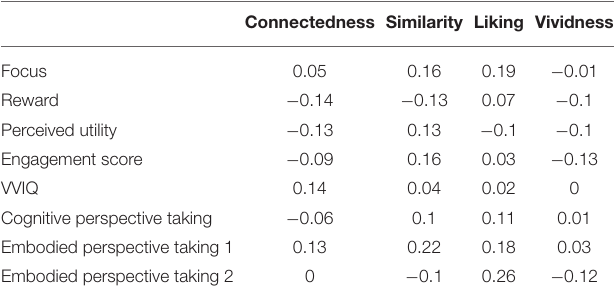
TABLE 3 | Correlations between of engagement subscales, embodiment, imaginative ability, and the difference scores from baseline to post-experiment in domains of future